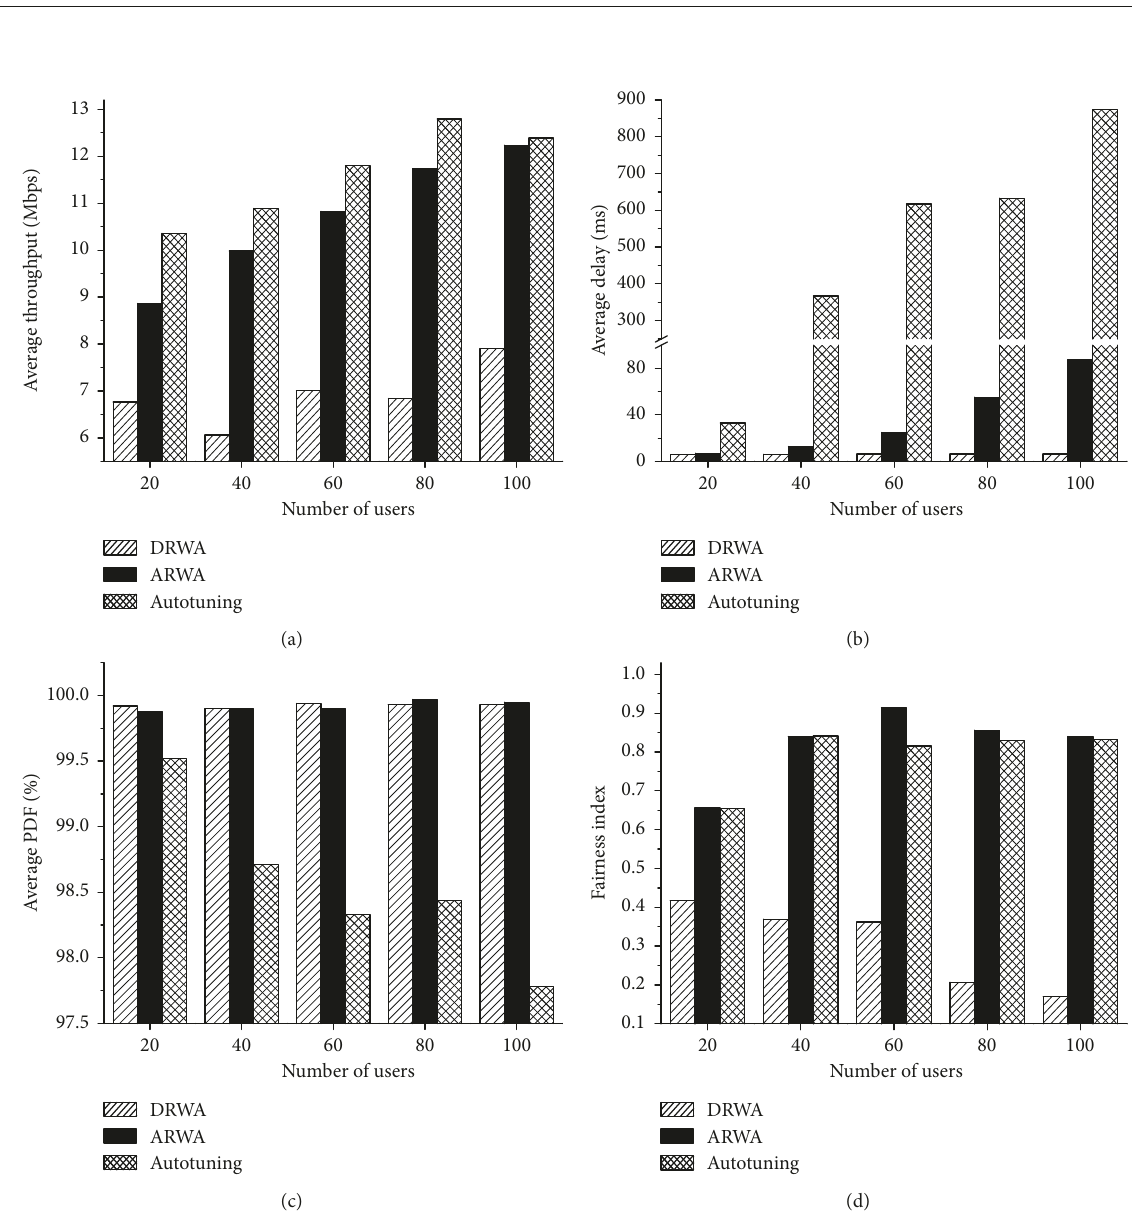
Figure 6: Performance of DRWA, ARWA, and autotuning methods for varying number of users in LTE network. (a) Average throughput. (b) Average delay. (c) Average PDF. (d) Fairness index.